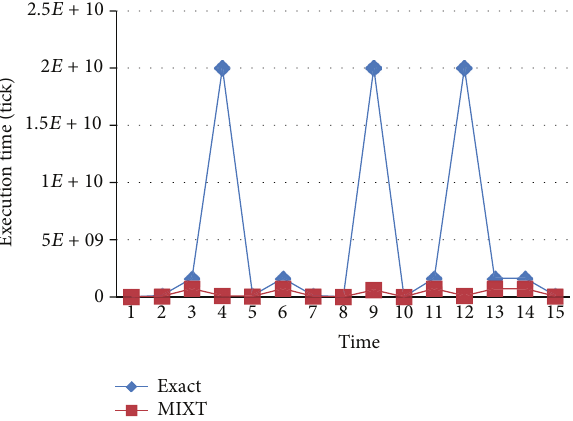
variationforexact,genetic(nbr it = exe